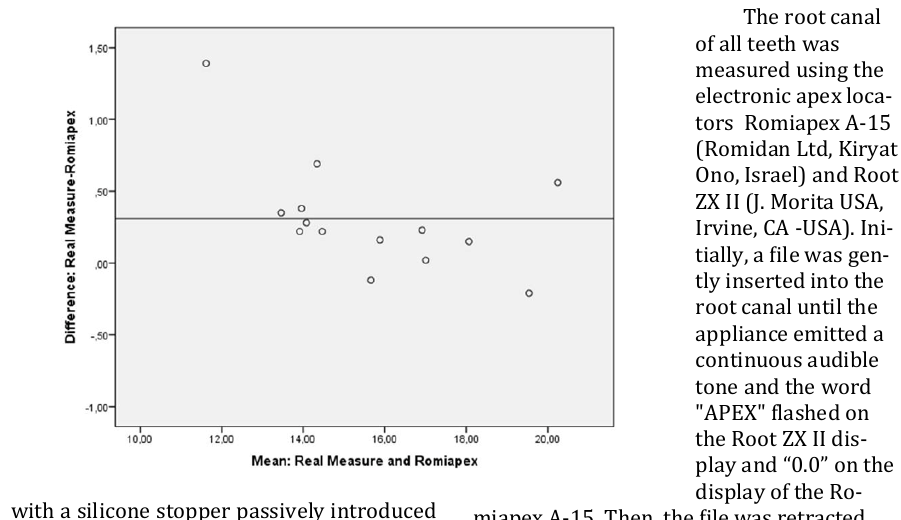
tained using the electronic apex locator Root ZX II and the real measurements.